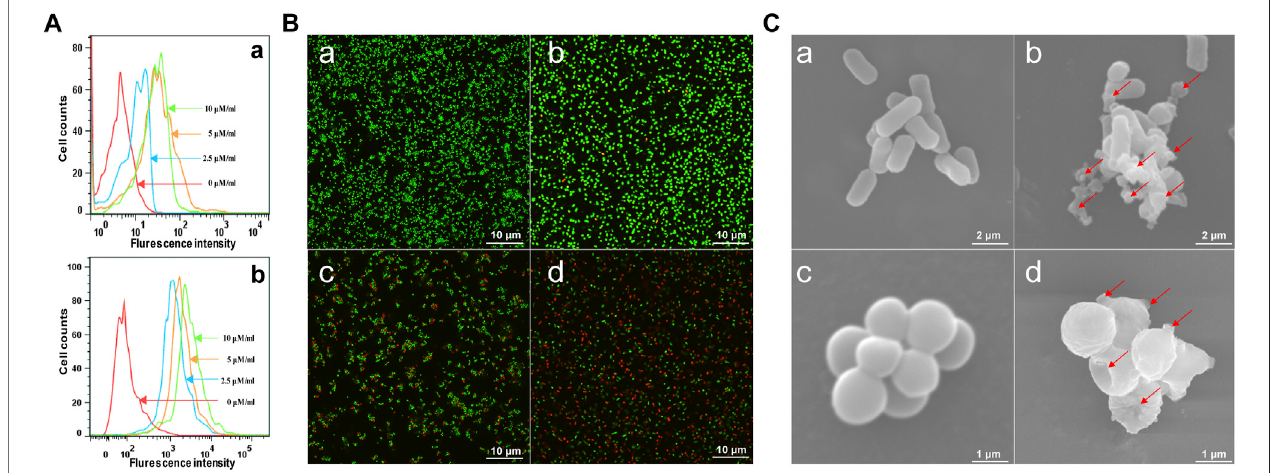
FIGURE 3 | Antimicrobial mechanism of brevinin-2MP. (A) Flow cytometry analysis of the interaction between FITC-labeled brevinin-2MP and S. aureus ATCC 25923 (a) as well as E. coli ATCC 25922 (b). (B) Confocal laser scanning microscopy. The bacteria treated with or without brevinin-2MP were stained with LIVE/DEAD